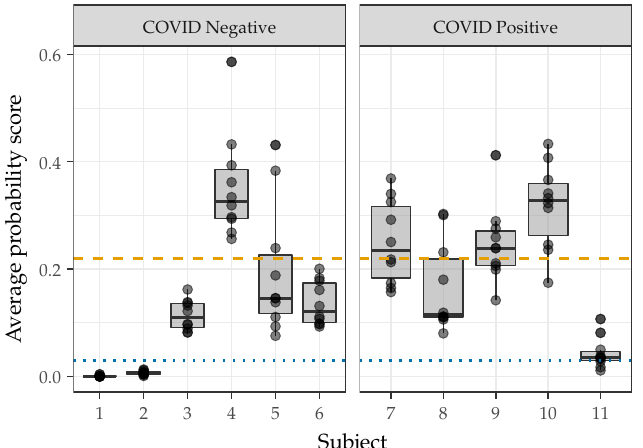
Figure 9. Average probability scores measured from eleven subjects counting in ten separate record- ings. The blue dotted line indicates the optimal classification threshold and yellow dashed line indicates the development